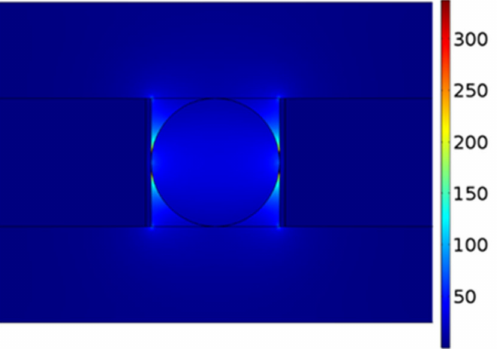
Figure 5. Waveguide electric field distribution with graphene as the dielectric